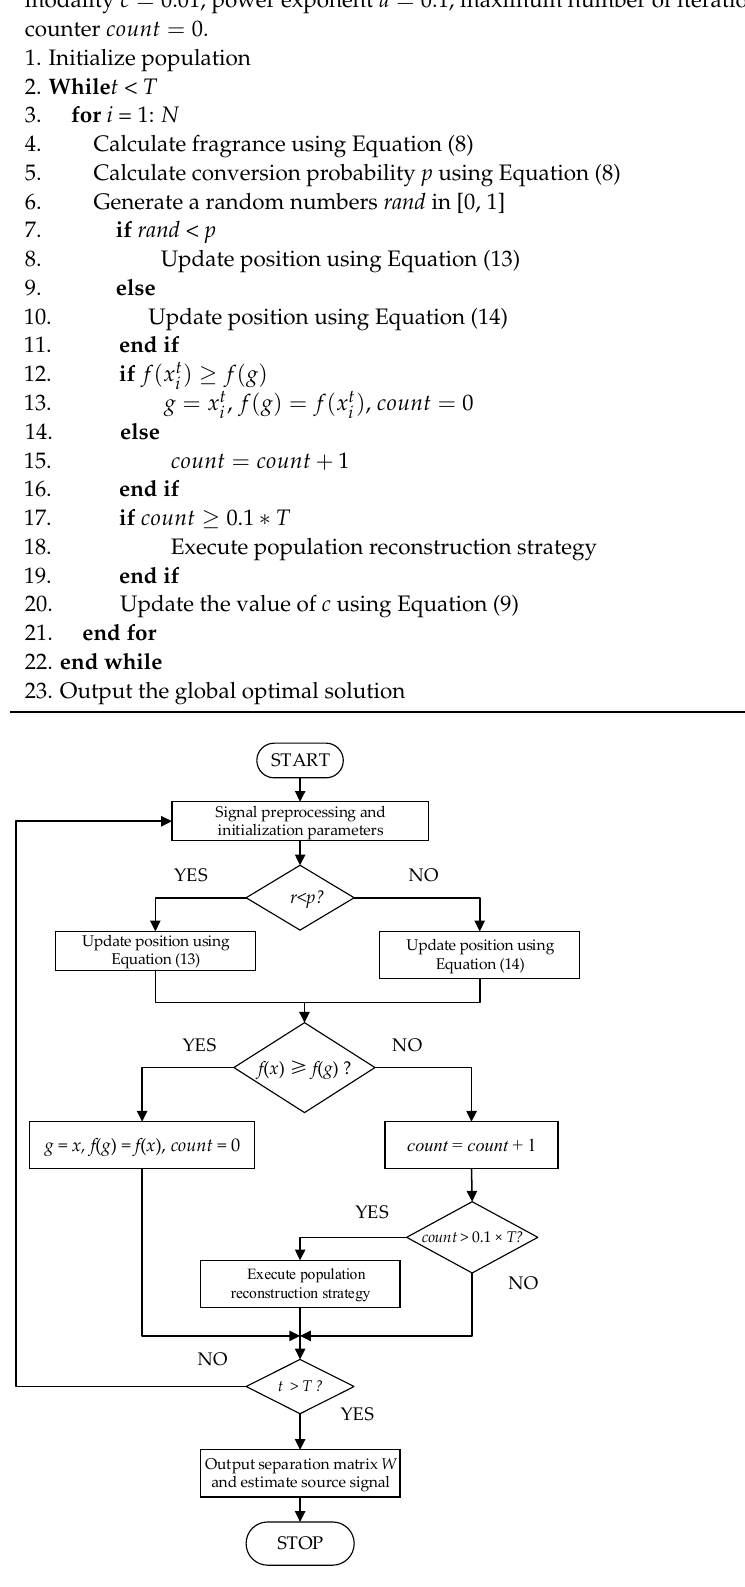
Figure 3. The flow chart of DMBOA ‐